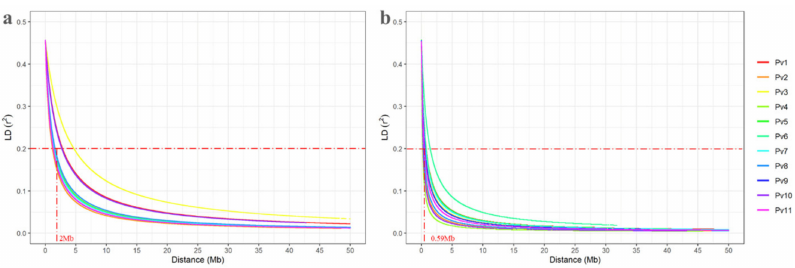
Figure 4. Linkage disequilibrium (LD) decay determined by the LD measurements (r 2 ) against the distance between SNPs (Mb) for the 11 chromosomes (Pv) adjusted according to the model proposed by Hill and Weir (1988). ( a ) Brazilian diversity panel controlled for population structure. ( b ) Carioca panel controlled for relatedness. The horizontal and vertical lines represent the standard LD decay thresholds (r 2 ) and distances (Mb),